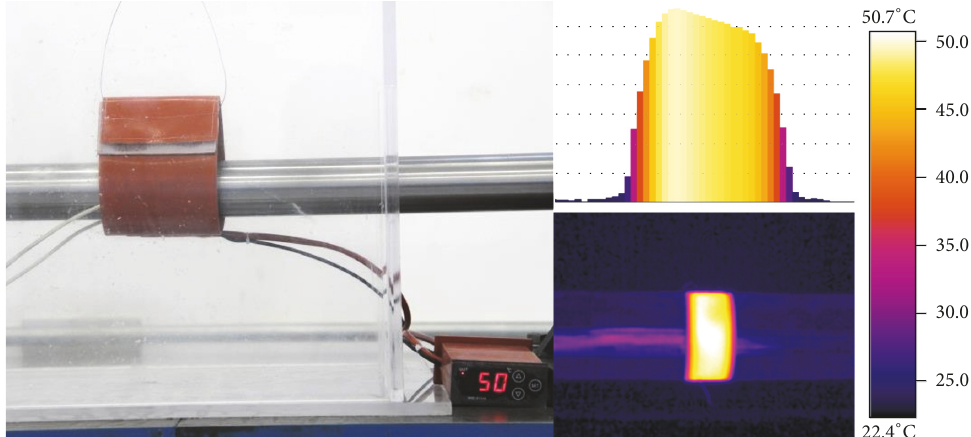
Figure 9: The temperature control device and the heated sample (50 ∘